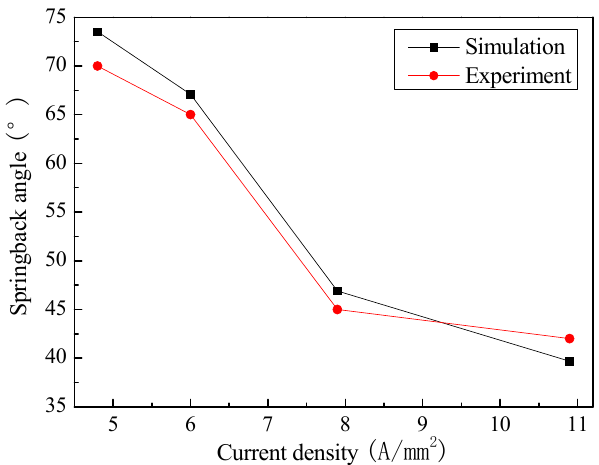
Figure 6. The springback angle comparisons between simulation and experiment.